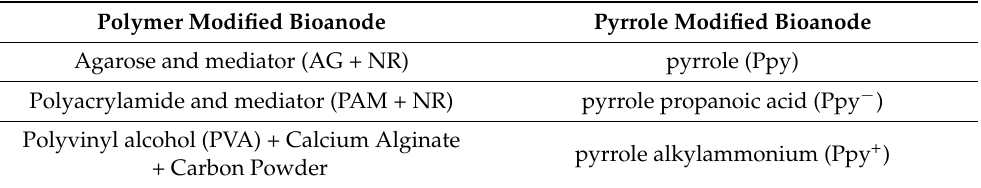
Table 3. Different anode modifications made for VFA sensing